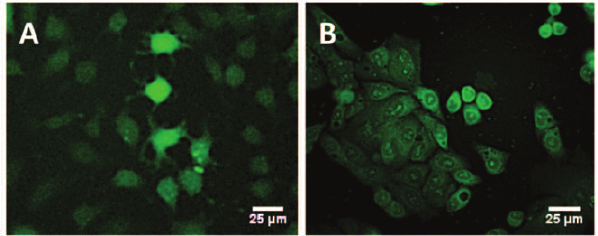
Figure 6. (A) Fluorescent imaging of spiroligomer 3 in Huh7 cells (spiroligomer 3 concentration 2 m M, incubated for 24 hours, washed with phosphate-buffered saline (PBS), followed by fixation of the cells. (B) HepG2 cells that were incubated with spiroligomer 1 (0.5 mM) for 15 hours, washed with PBS and then imaged with fluorescent microscopy (concentration 0.5 m M), incubated for 15 hours and then imaged.